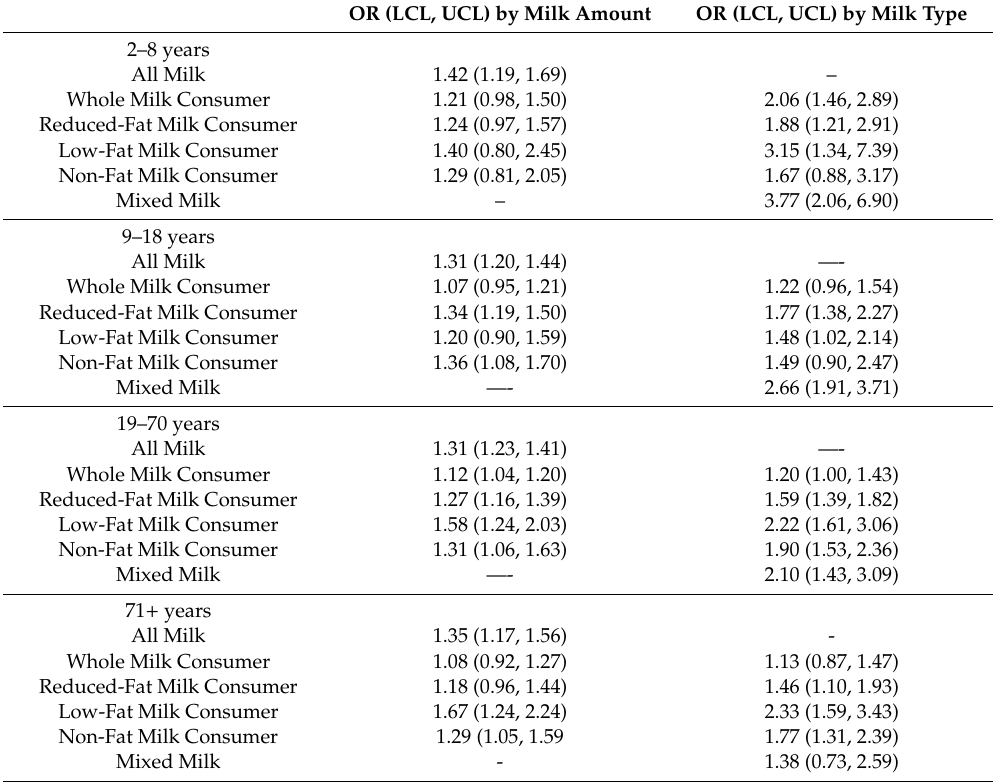
Table 6. Odds ratios (OR), 95% confidence limits (Lower confidence limit (LCL) / Upper confidence limit (UCL)) for meeting the recommended serum vitamin D ( > 50 nmol / L), NHANES